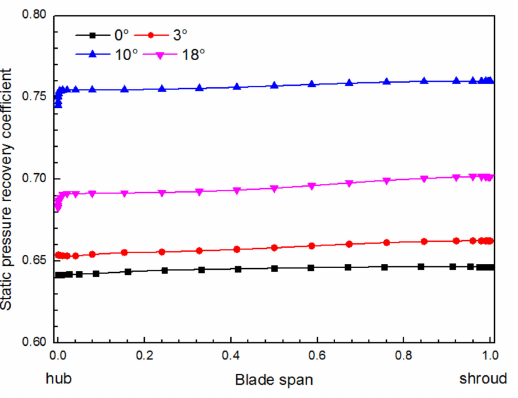
Figure 7. Variation of the static pressure recovery coefficient along blade spanwise